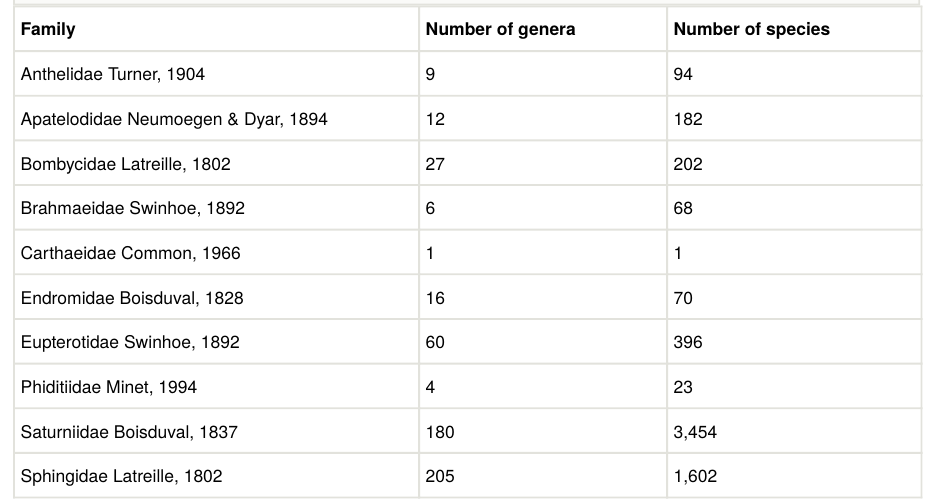
Number of valid genus and species names in each of the ten families of